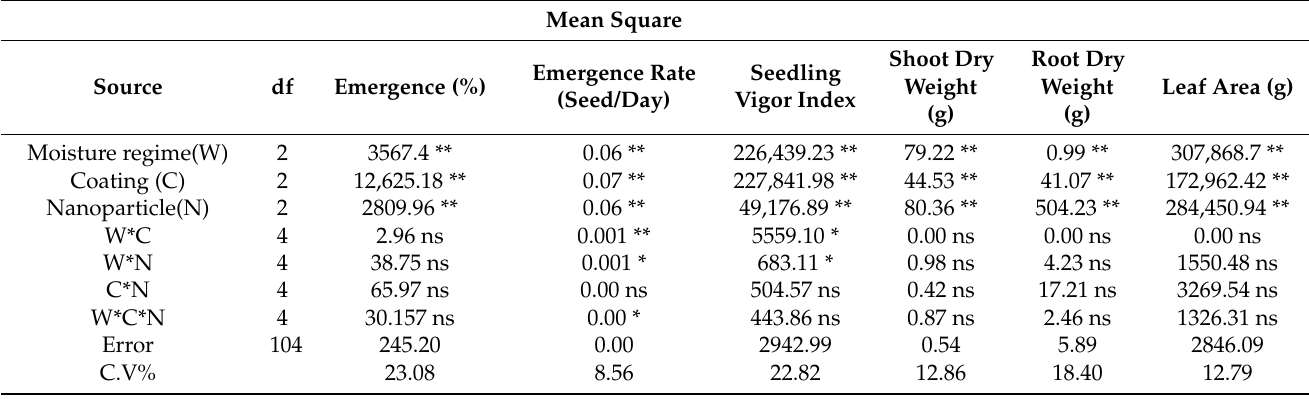
Table 4. Analysis of variance for emergence, emergence rate, seedling vigor index, shoot dry weight, root dry weight, and leaf area as affected by moisture regime, coating, and nanoparticle.